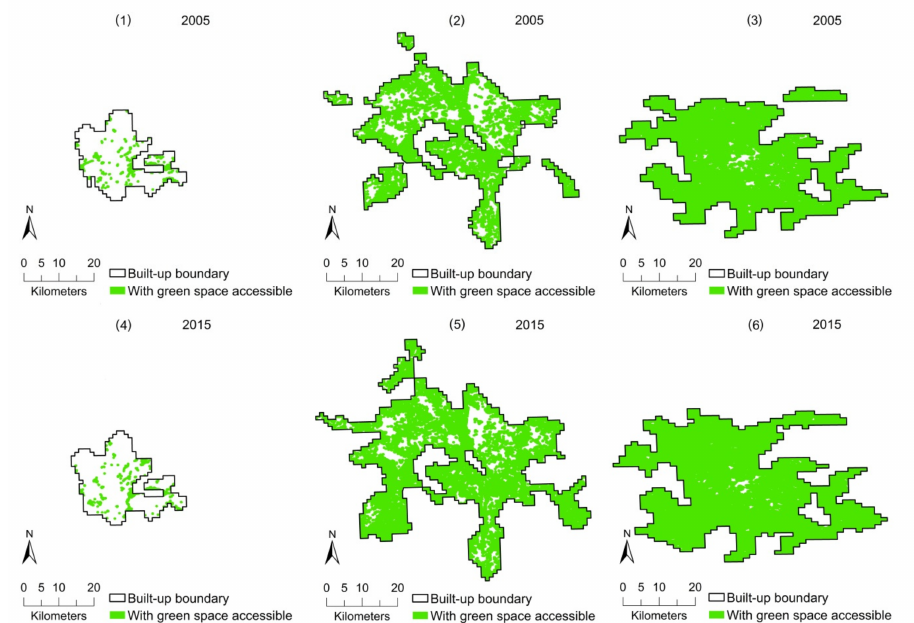
Figure 3. Distribution of urban green spaces ( ≥ 1 ha) and their 300 m buffered areas, examples for megacities of: low (Karachi) ( 1 ), median (Delhi) ( 2 ), and high (Moscow) ( 3 ) values of accessibility indicator in 2005; and low (Karachi) ( 4 ), median (Delhi) ( 5 ), and high (Moscow) ( 6 ) values of accessibility indicator in 2015.